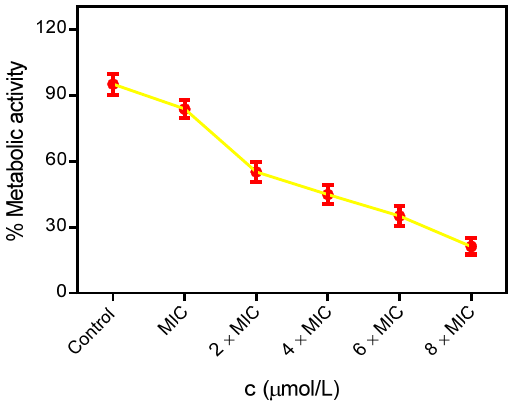
Figure 9. Decrease in metabolic activity of C. tropicalis treated with increasing concentrations of thioether benzimidazole 7f .